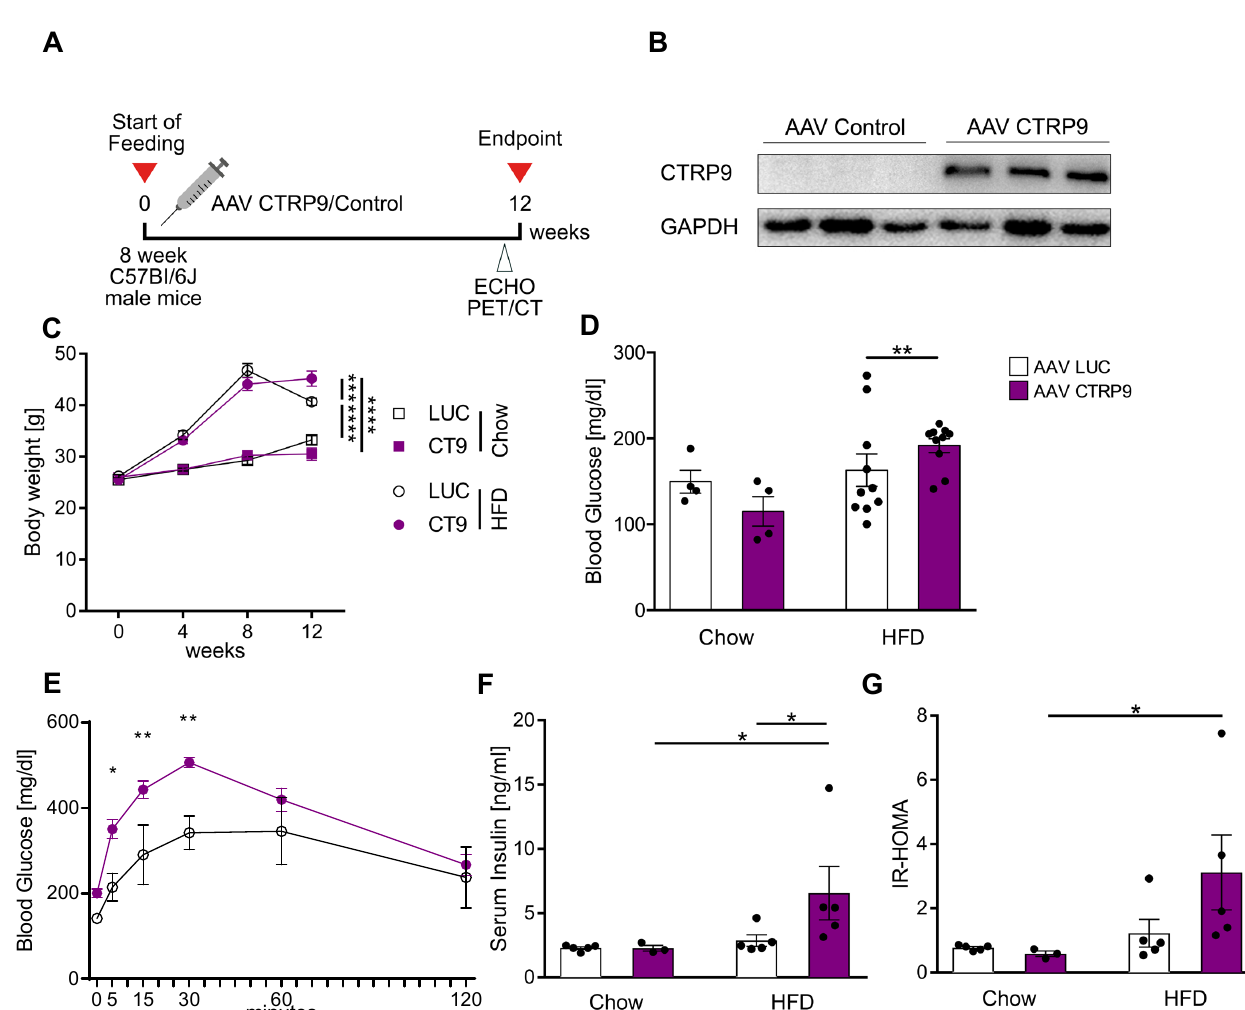
Figure 4. Cardiac overexpression of CTRP9 leads to peripheral insulin resistance during administra- tion of a high-fat diet (HFD). ( A ) Scheme showing the experimental timeline. ( B ) Immunoblotting for CTRP9 from cardiac protein lysate of mice treated either with AAV Luc (control, LUC) or AAV CTRP9 (CT9, leading to myocardial CTRP9 overexpression). ( C ) Body weight measured at 4, 8 and 12 weeks in the indicated mice after start of feeding. ( D ) Fasted serum glucose levels. ( E ) Glucose tolerance test in the indicated mice after 12 weeks of HFD. ( F ) Serum insulin levels. ( G ) HOMA-Index of insulin resistance. Data are shown as mean ± standard error of the mean (SEM). * p < 0.05, ** p < 0.01, *** p < 0.001, **** p < 0.0001